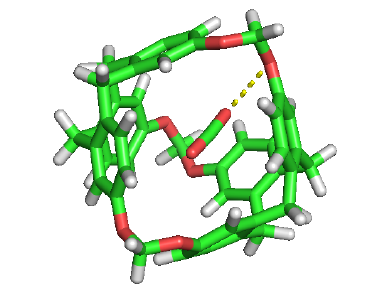
Figure 9. CO 2 guest molecule interaction with the ether group inside the cavity.